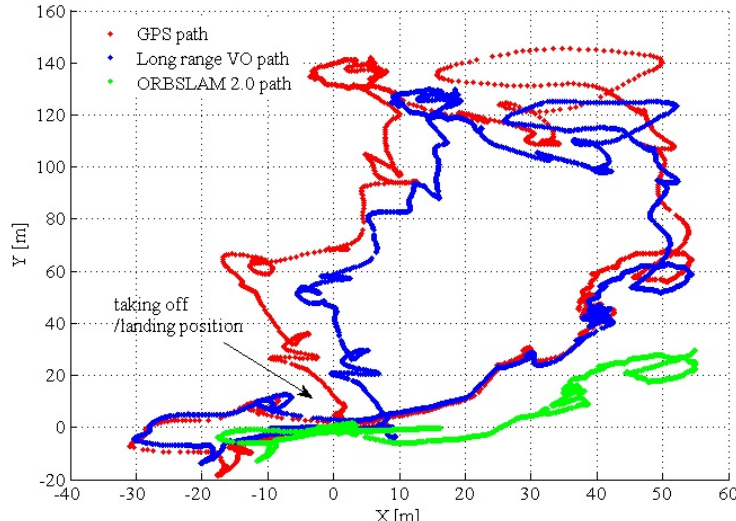
Figure 13. Comparison of the GPS path, proposed long-range VO path and ORBSLAM 2.0 path. The MAV takes off at position (0,0). At this position, we recorded the initial GPS and barometric measurements as the offsets for the subsequence ground truth measurements. The initial MAV heading is aligned with the NED coordinate. ORBSLAM 2.0 (also with IMU tightly coupled) fails at 400 s of the dataset.